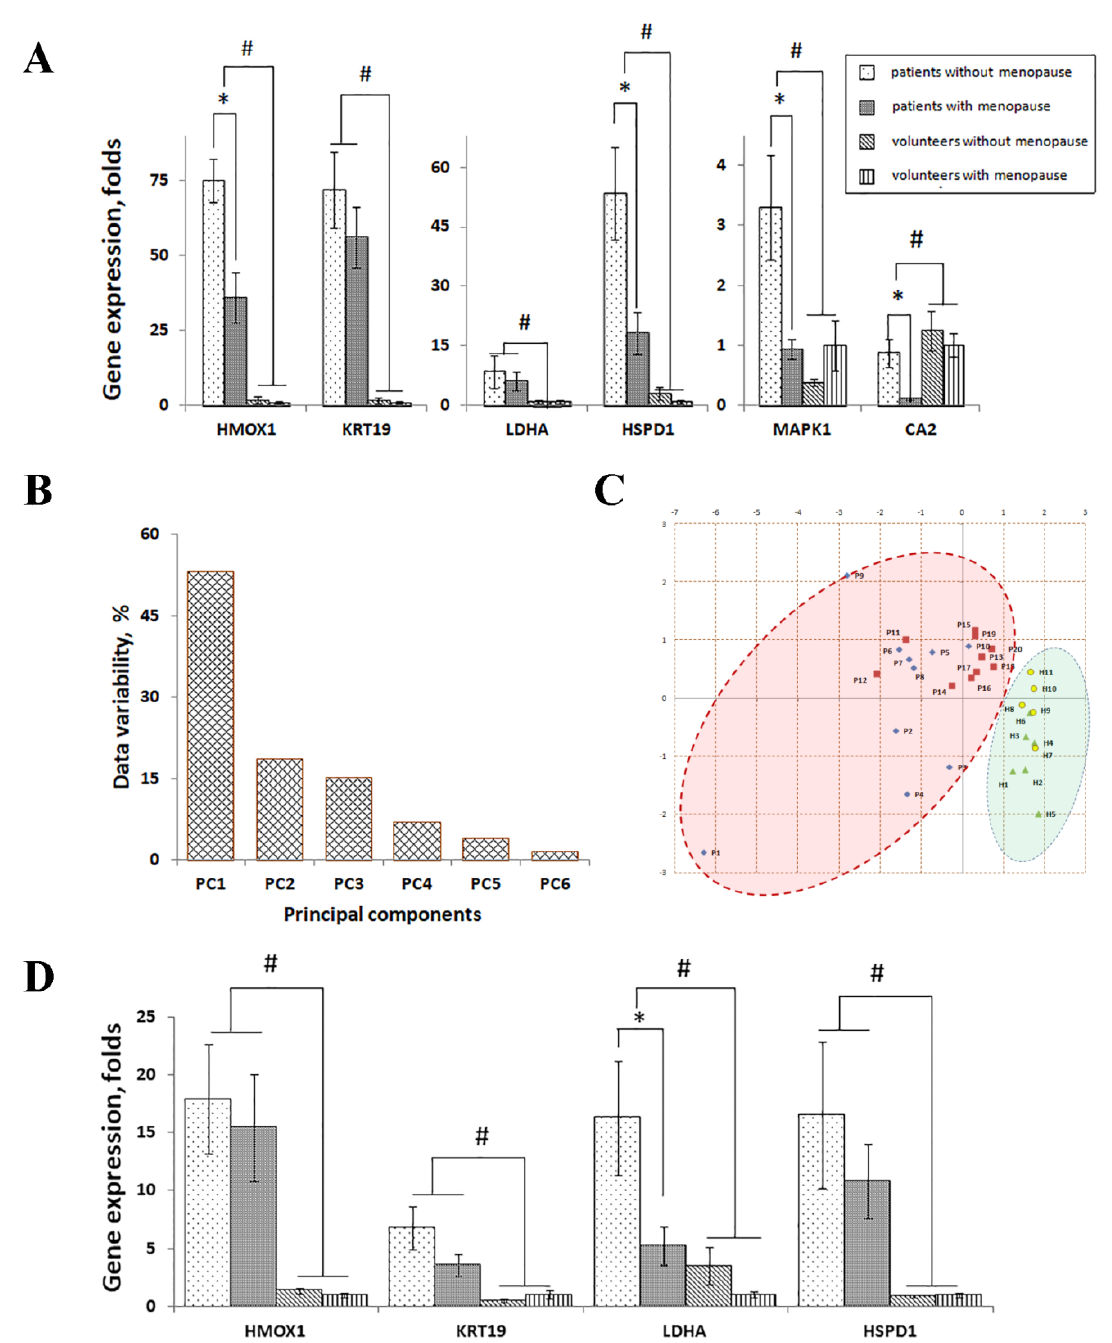
Figure 3. The expression of identified estrogen-responsive genes in clinical samples of psoriasis patients and healthy volunteers assessed by qPCR. ( A ). The levels of gene expression in the samples of patients’ lesional skin and in the skin of healthy volunteers. ( B ). Assessment of a variation in gene expression in the lesional skin of psoriasis patients and healthy volunteers by principle component analysis. ( C ). The plot of two first principal components (PC1 and PC2). Different groups are indicated by data points of different colors and shapes: group 1 is represented by blue diamonds; group 2 is represented by red squares; group 3 is represented by green triangles; and group 4 is represented by yellow circles. ( D ). The expression of identified estrogen-responsive genes in the PBMC obtained from the blood of patients and healthy volunteers. The following individuals participated in these experiments: psoriasis patients without menopause (n = 10); psoriasis patients with menopause (n = 10); healthy volunteers without menopause (n = 6); and healthy volunteers with menopause (n = 5). * p < 0.05 when women without menopause compared to women with menopause. # p < 0.05 when patients compared to healthy volunteers. Gene expression in menopausal patients was set equal to 1.